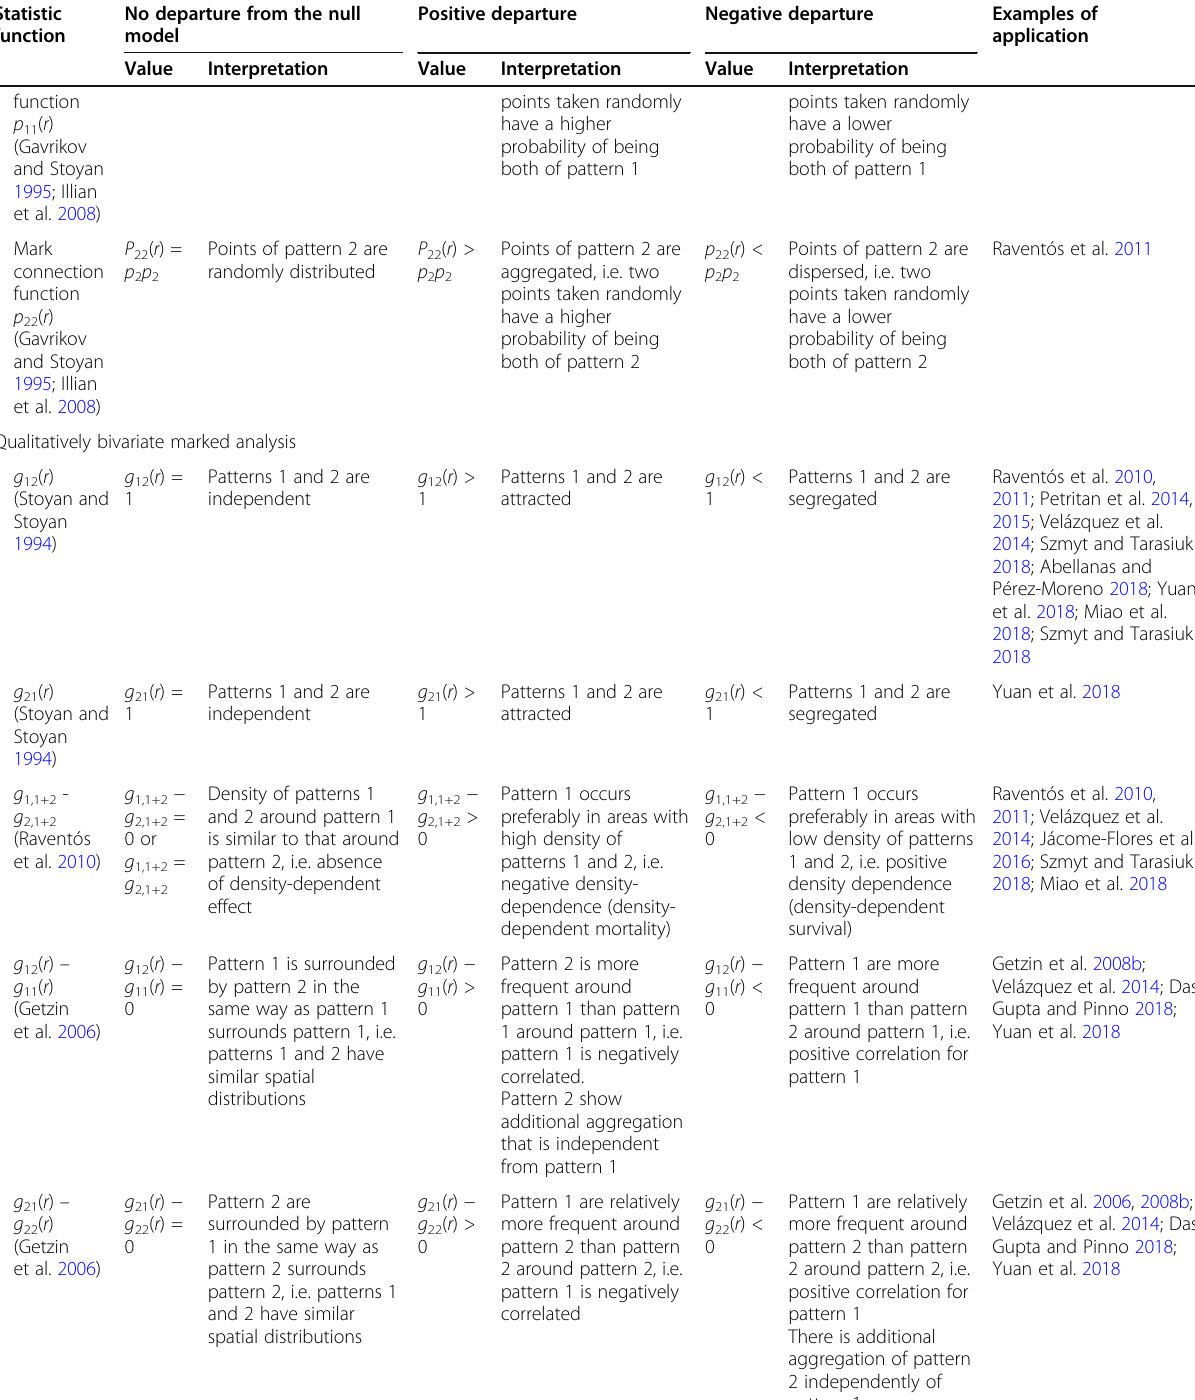
Table 1 Second-order summary statistics commonly used in spatial point-pattern analysis. In the univariate analysis, only one pattern is involved (e.g. one species, one size or age class, one life stage, etc.), while in the bivariate version two patterns (1 and 2) are investigated (e.g. two different species, two size classes, two life stages, etc.). For the mark correlation analysis, the most studied mark is by far tree diameter. In the case of random labelling analysis, the marks usually consist of tree status (e.g. dead vs living). For all analysis types, positive, negative, or absence of departure from the null model simulation envelopes occurs at a given scale